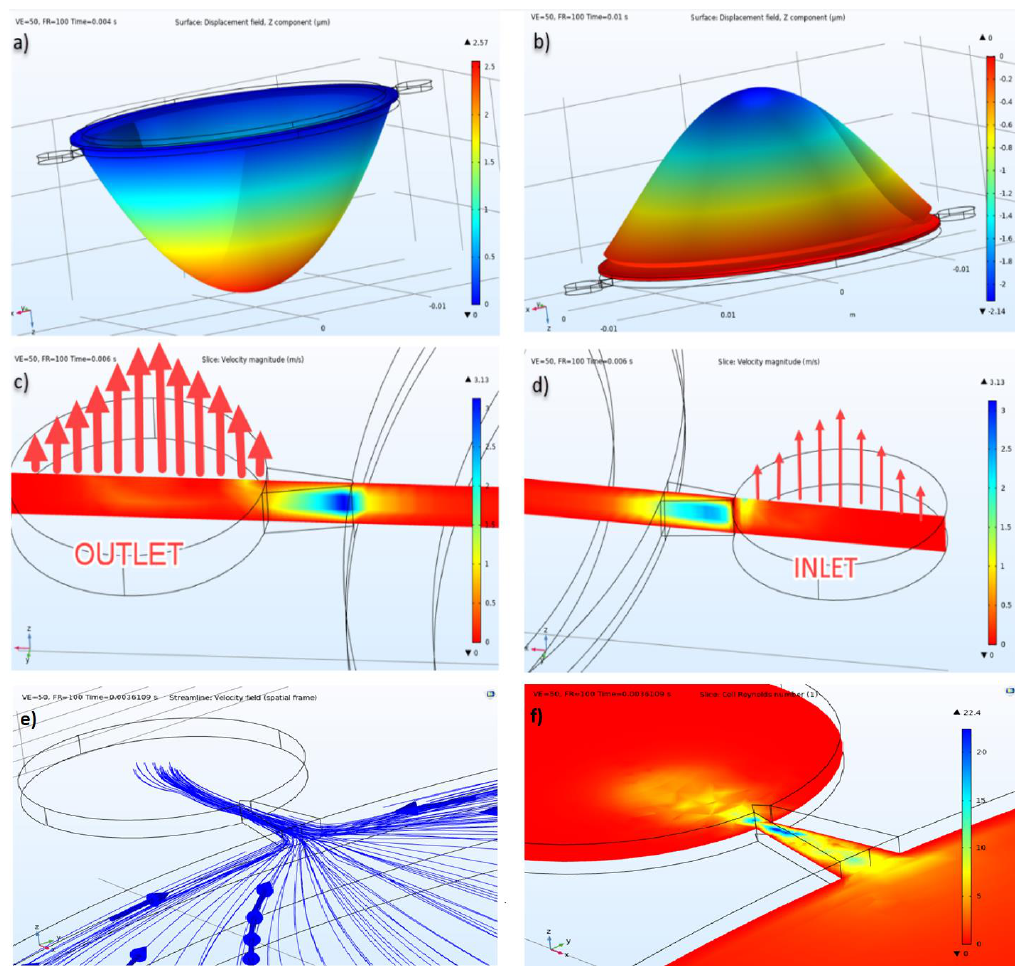
Figure 3. ( a ) Displacement of the piezoelectric actuator at pumping mode, ( b ) suction mode, ( c ) inlet velocity illustration, ( d ) outlet velocity illustration at the same time, ( e ) velocity field streamlines, ( f ) cell Reynold’s number.